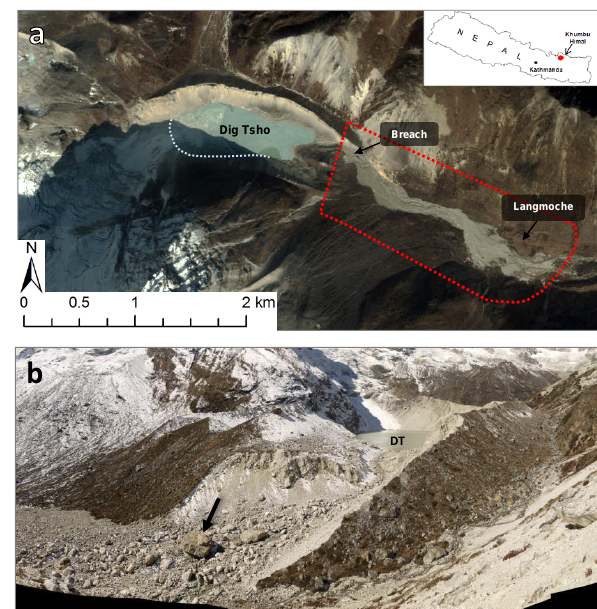
Figure 1. The Dig Tsho moraine dam and upper reaches of the Langmoche Khola. (a) True-colour GeoEye imagery of the study site. Extensive reworking of the valley floor by escaping floodwa- ters is evident immediately downstream of the moraine breach. Red dashes indicate two-dimensional model domain. (b) The moraine- dam breach, formed by the 1985 GLOF. For scale, the boulder in- dicated by the black arrow is > 10m in height and diameter. The breach is ∼ 200m at its widest point, and has a maximum depth of 60m. The relict Dig Tsho glacial lake is visible in the back- ground (DT). The progressive concentration of such boulders in the breach thalweg during moraine down-cutting and side-wall failure may have served to modify the final breach